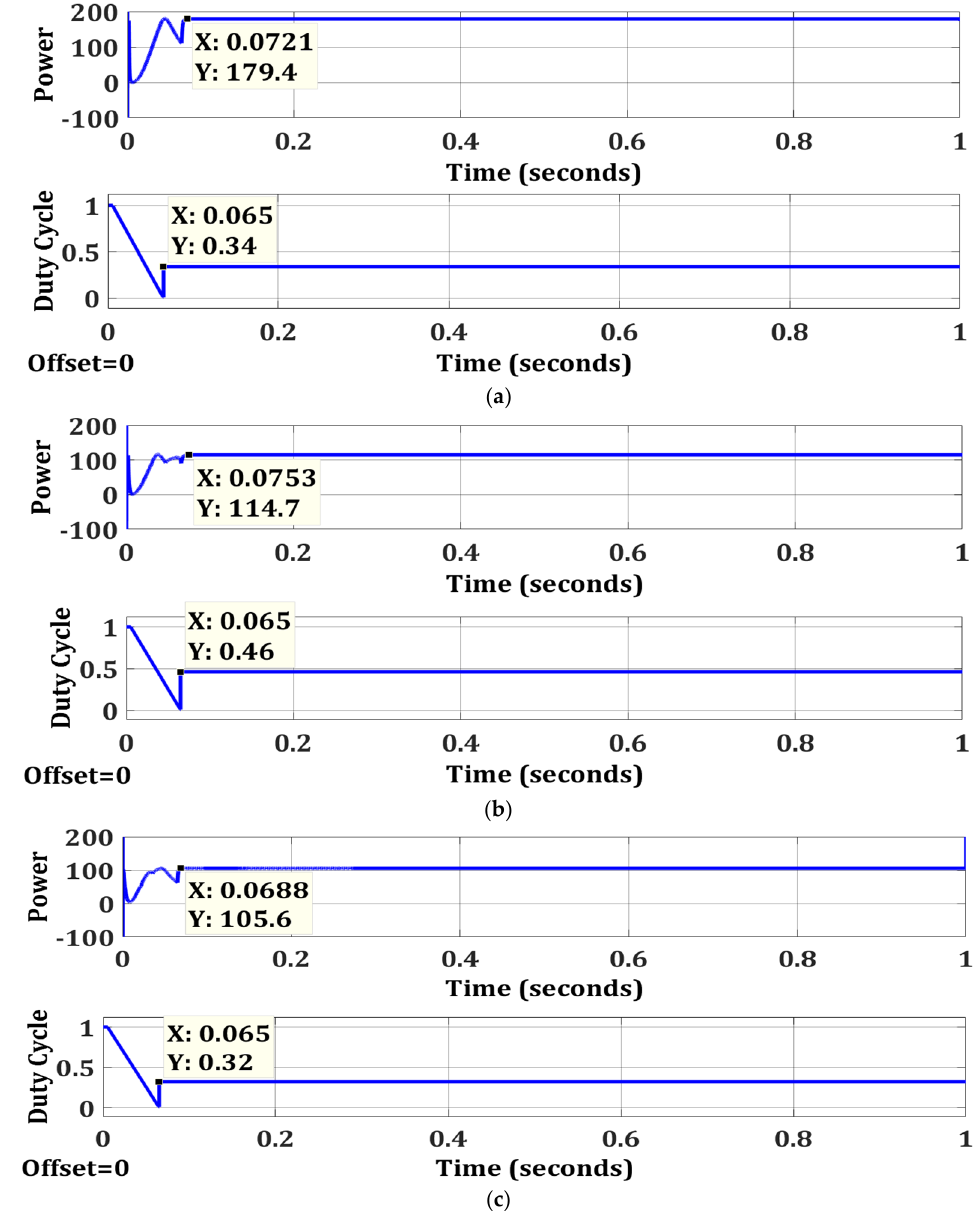
Figure 28. Simulation results for 3S2P PV system: ( a ) ten check algorithm for test case 1; ( b ) ten check algorithm for test case 2; ( c ) ten check algorithm for test case 3.